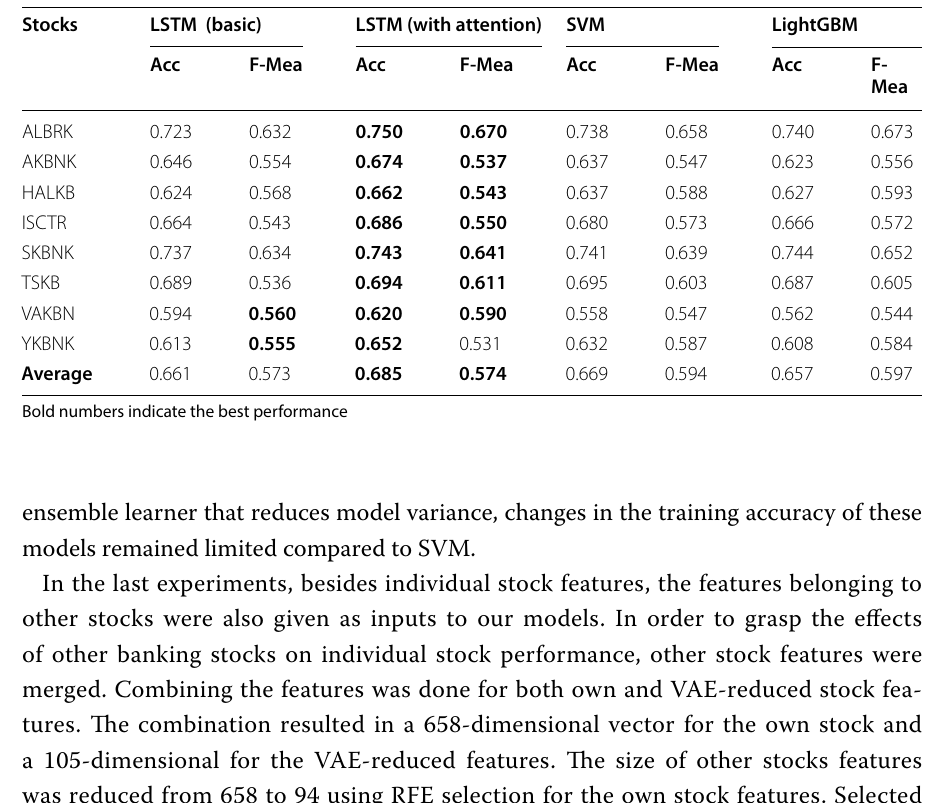
Table 10 Classification results using allstock_own features